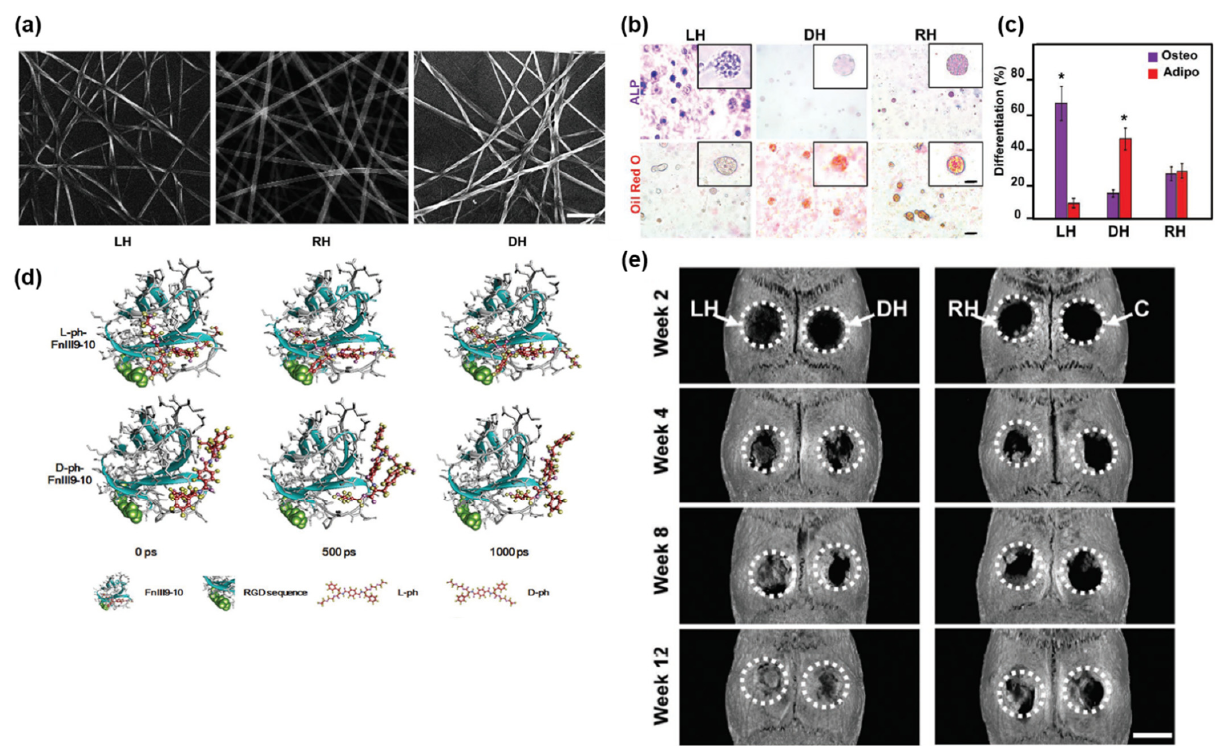
Figure 9. ( a ) SEM images of left-handed matrix (LH), racemic matrix (RH) and right-handed matrix (DH), scale bar = 200 nm. ( b ) Alkaline phosphatase (ALP) and lipid droplet (Oil Red O) staining results. ( c ) Differentiation percentage of mesenchymal stem cells (MSCs). * p < 0.05, t -test. ( d ) Snapshots of the molecular dynamic simulations illustrating the effect of chirality on fibronectin (Fn) tethering. ( e ) CT images of bone regeneration in rat cranial defects after MSC/matrix implantation, scale bar = 5 mm. Reprinted with permission from Ref. [31] . Copyright 2019 John Wiley and Sons.